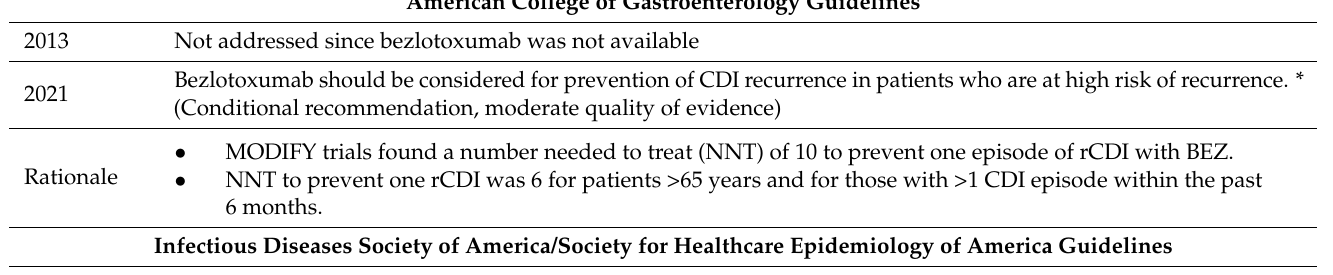
Table 1. Comparison of the IDSA/SHEA and ACG clinical practice guidelines. American College of Gastroenterology